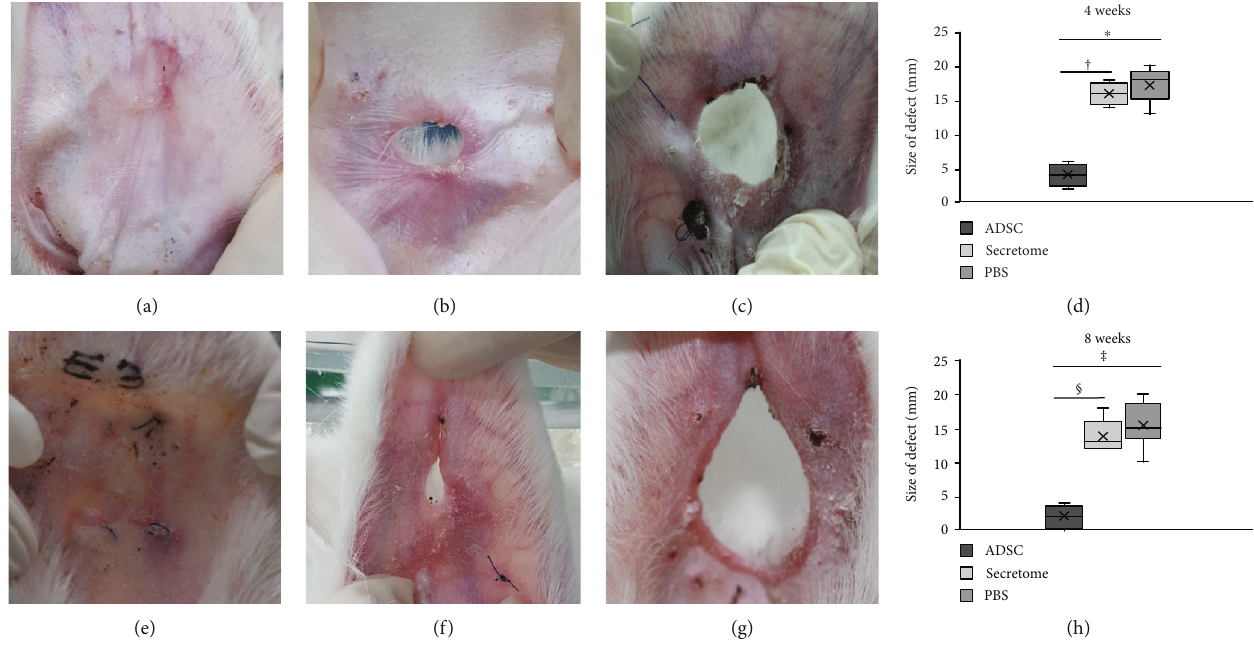
Figure 2: Gross auricular cartilage fi ndings. (a) Four weeks after ADSC injection, the defects were fi lled with soft pinkish tissue. The defects of the secretome (b) and PBS (c) groups remained evident. The defect size decreased signi fi cantly in the ADSC compared to the secretome or the PBS group at 4 (d) and 8 weeks (H) after ADSC injection. (e) In ADSC-treated ears, the defects were completely healed by 8 weeks; the tissue surface was smooth and of similar color to that of the surrounding tissue. The secretome (f) and PBS (g) groups exhibited minimal defect repair. ∗ , † , ‡ ,§ p < 0 : 001 . ADSCs: adipose-derived stromal cells; PBS: phosphate-bu ff ered